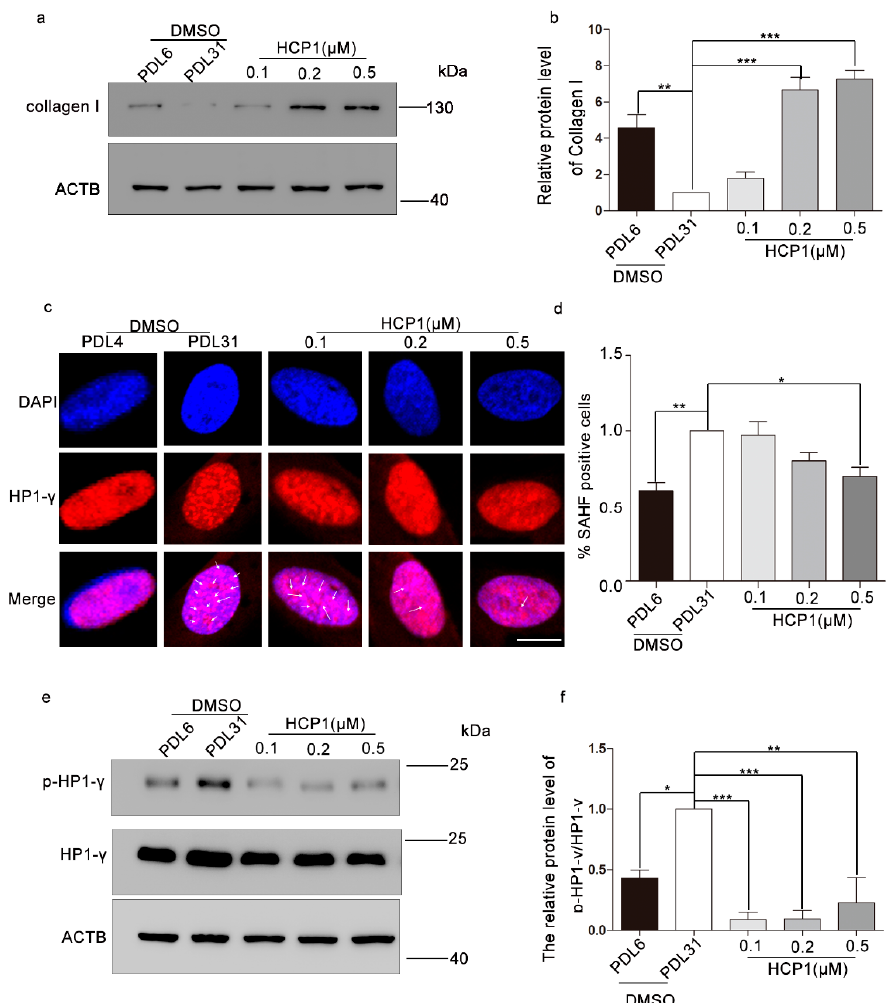
Figure 3. Effects of HCP1 on Collagen I and SAHF in senescent HDFs. ( a , b ) After senescent HDFs (PDL = 31) were treated with DMSO or HCP1 (0.1, 0.2, and 0.5 µ M) for 48 h, the protein level of Collagen I was detected by Western blot. ( c , d ) After DMSO or HCP1 (0.1, 0.2, 0.5 μ M) treated senescent cells for 48 h, immunofluorescence experiments were performed with HP1- γ antibody and DAPI to detect the aggregation of HP1- γ and statistical analysis. White arrows indicate deepened spotted areas. Scale bar: 20 μ m ( e , f ) Senescent HDFs treated with DMSO or HCP1 (0.1, 0.2, and 0.5 μ M) for 48 h. The phosphorylation level of HP1 γ was detected by Western blot. DMSO treated- healthy HDFs as positive controls. Data are presented as means ± SEM, * p < 0.05, ** p < 0.01, *** p < 0.001, n = 3.